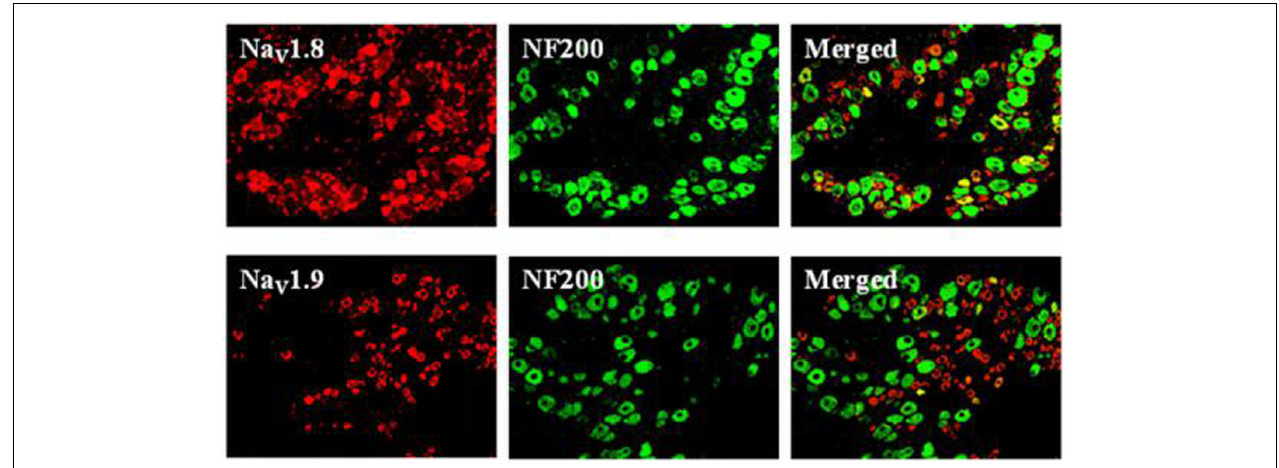
FIGURE 4 | Expression profiles of Na V 1.8 and Na V 1.9 in DRG neurons ( × 200). Double immunofluorescent labeling of L 4 − 6 DRG neurons by anti-Na V 1.8 (red) and anti-NF200 (green) or anti-Na V 1.9 (red) and anti-NF200 (green) antibodies.